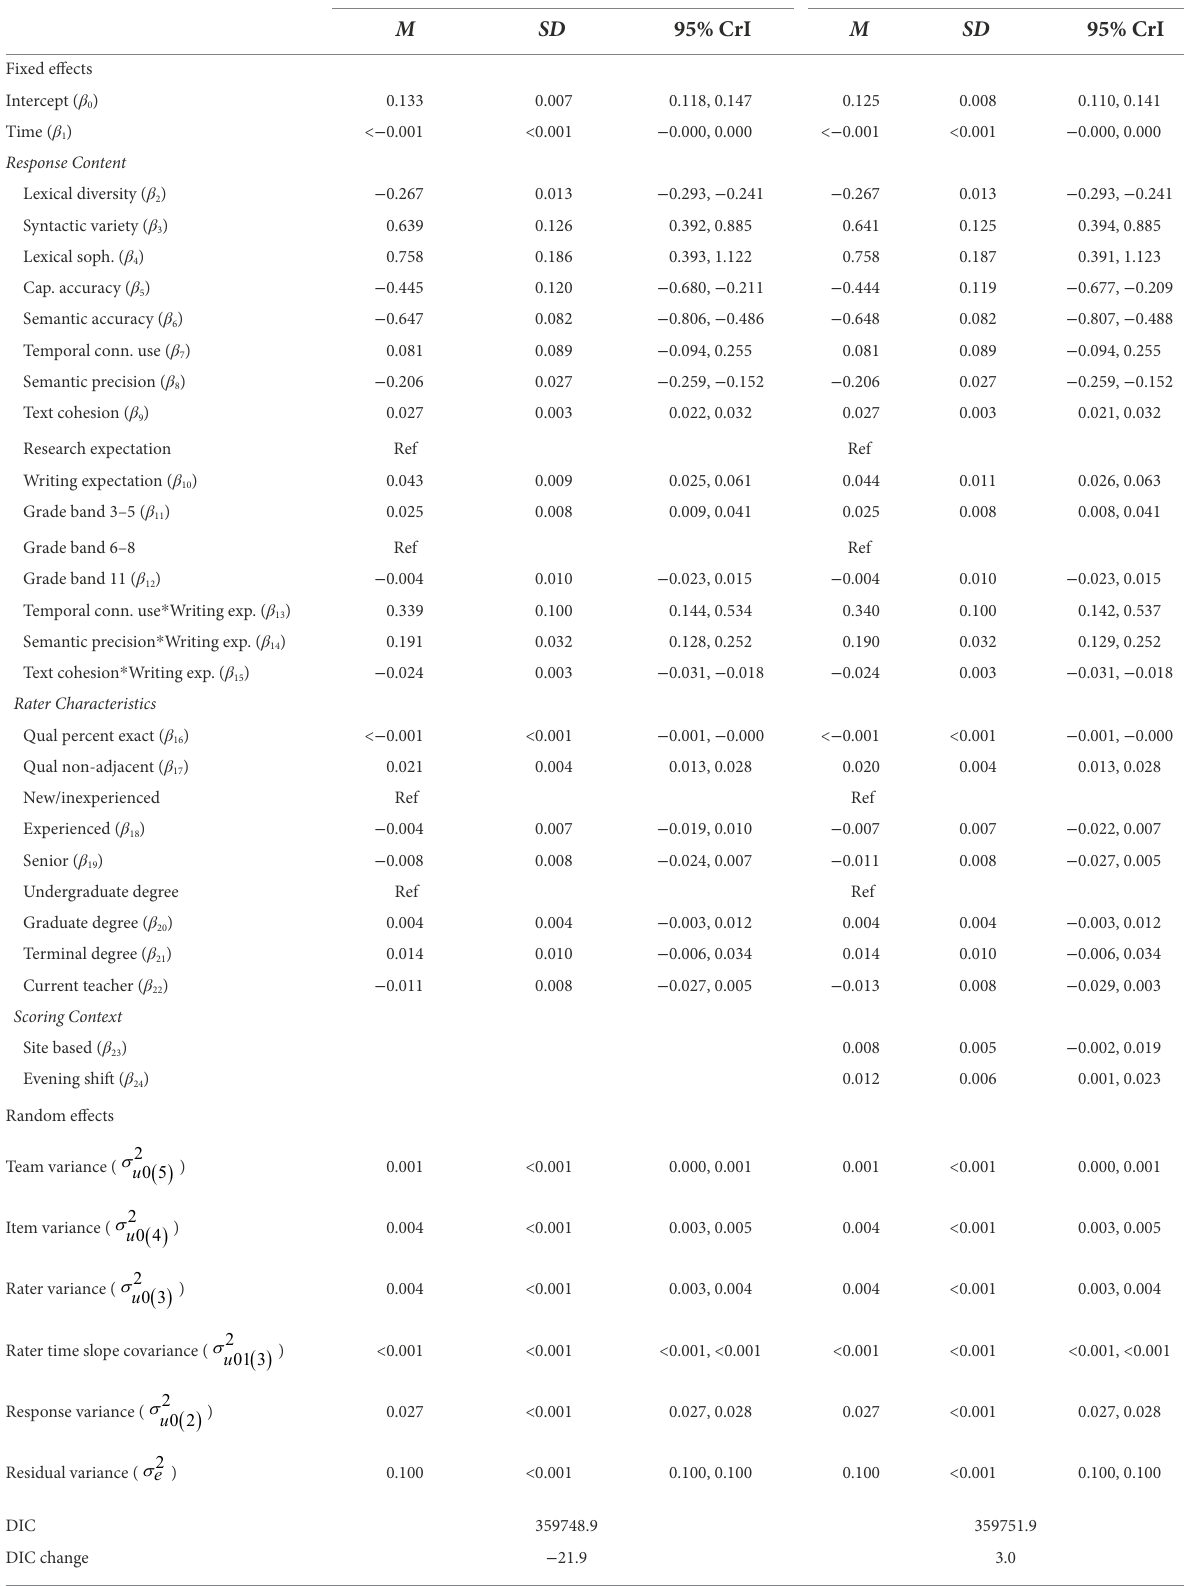
TABLE 5 Parameter estimates for models 5 and